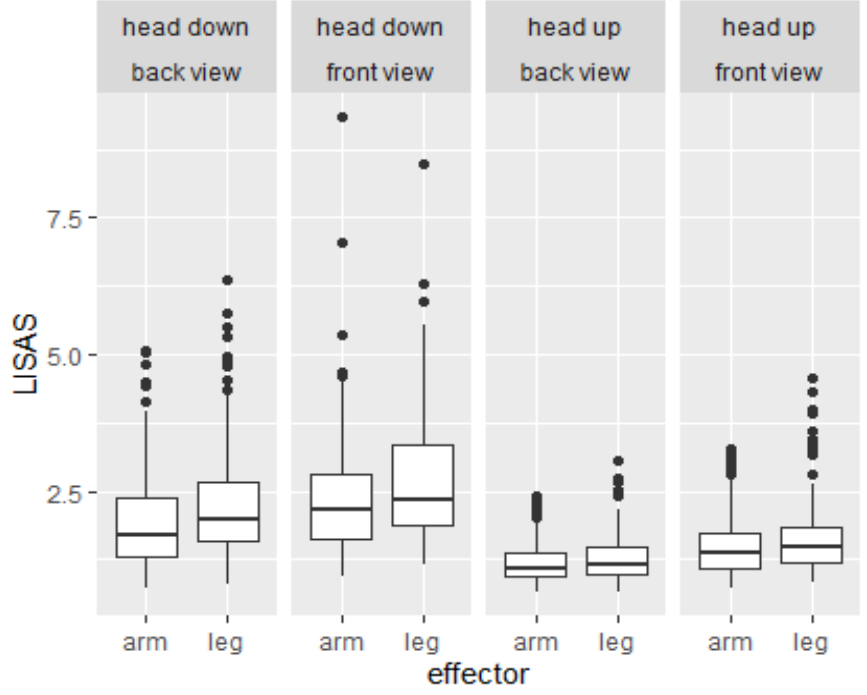
Figure 2. Boxplots of the linear integrated speed-accuracy scores (LISAS) depending on rotation (head-down, head-up), perspective (back view, front view), and limb (arm, leg) in Study 1. The significant main effect of perspective , F (1, 152) = 121.7, p < 0.001, η p 2 = 0.45, indicated significantly higher scores in the front view ( M ± SD = 2.1 ± 1.1) than the back view ( M ± SD = 1.7 ± 0.9). The significant main effect of rotation , F (1, 152) = 360.7, p < 0.001, η p 2 = 0.7, indicated significantly higher scores in head-down rotations ( M ± SD = 2.4 ± 1.1) than head-up rotations ( M ± SD = 1.4 ± 0.6). The significant main effect of limb , F (1, 152) =